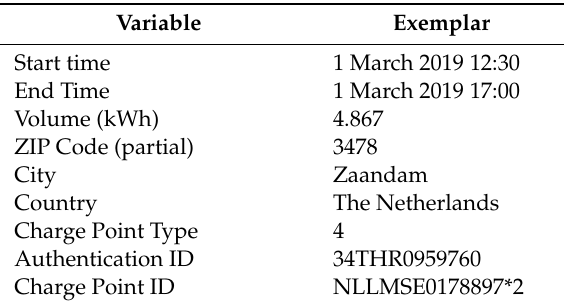
Table 1. Data description.